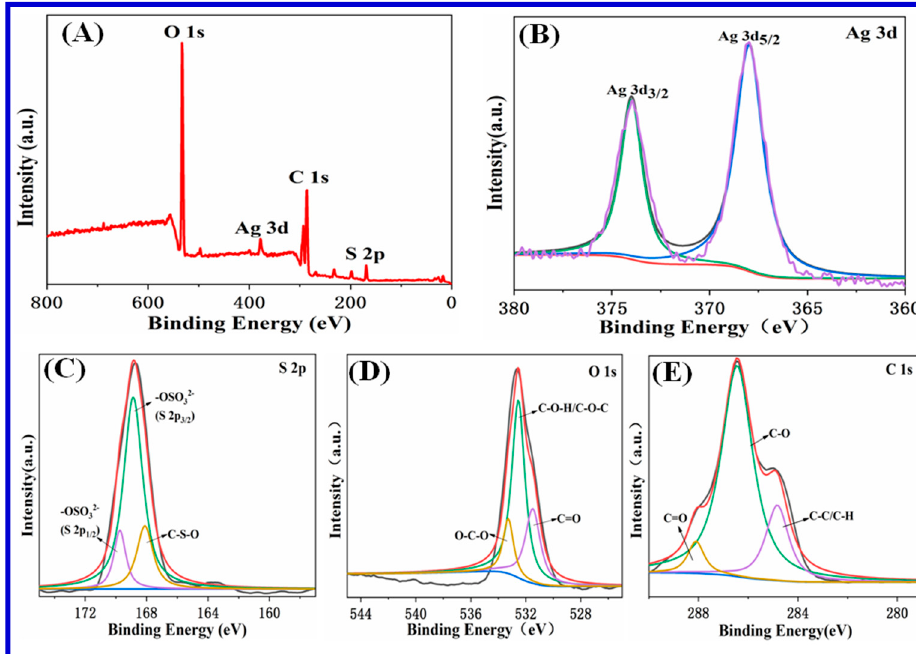
Figure 4. ( A ) X-ray photoelectron spectroscopy (XPS) full scan spectrum of carrageenan-AgNPs, ( B – E ) high resolution XPS spectrum for Ag 3d, C 1s, S 2p, and O 1s, respectively.